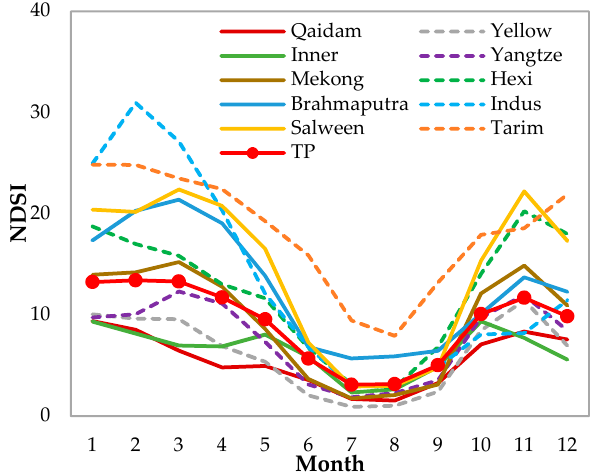
Figure 14. Annual cycle of average NDSI in different subregions (see Figure 1) over the TP during 2001–2017.